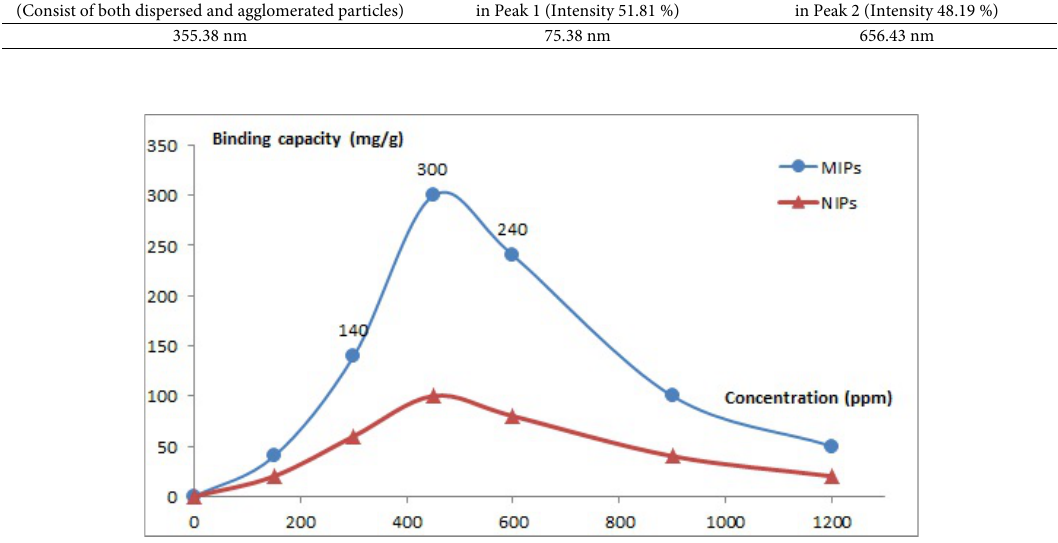
Fig. 5. The Binding Capacity Vs. Feed Concentration